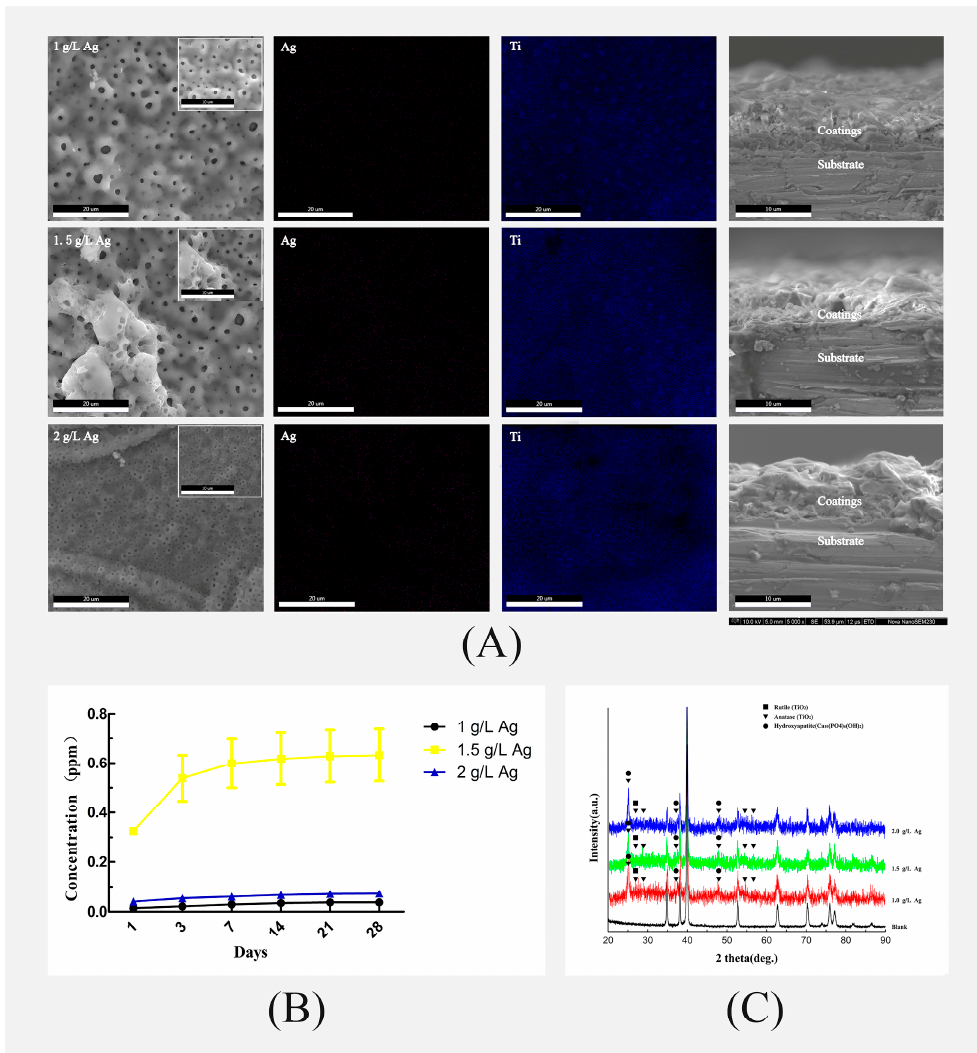
Figure 1. ( A ) Representative SEM images of scaffold surfaces and EDS mapping of the Ag-coated groups; ( B ) XRD patterns of plasma electrolytic oxidation (PEO)-treated and PEO-untreated samples; ( C ) cumulative release profiles of Ag ions measured during a period of 28 days.